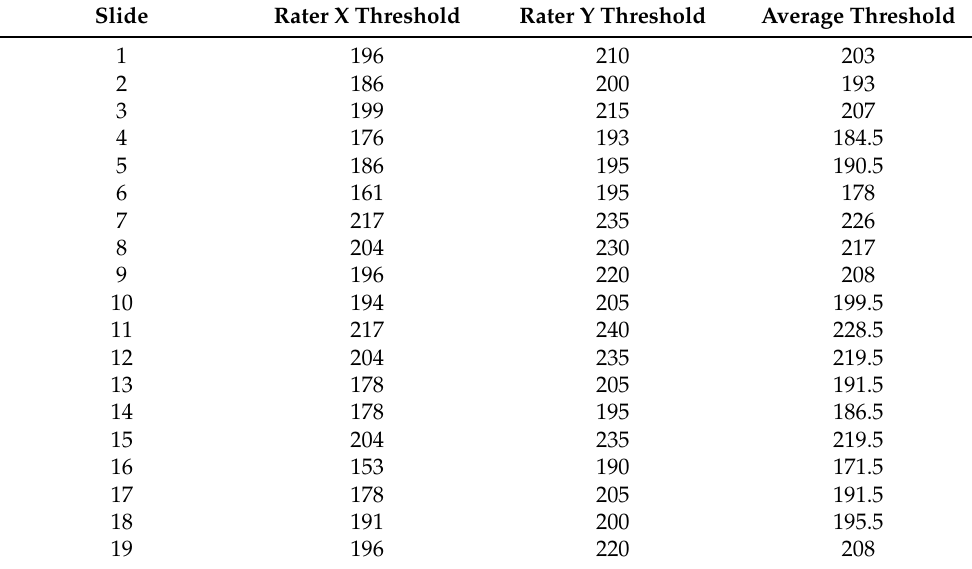
Table 3. Thresholds used in the separation filter for the sample